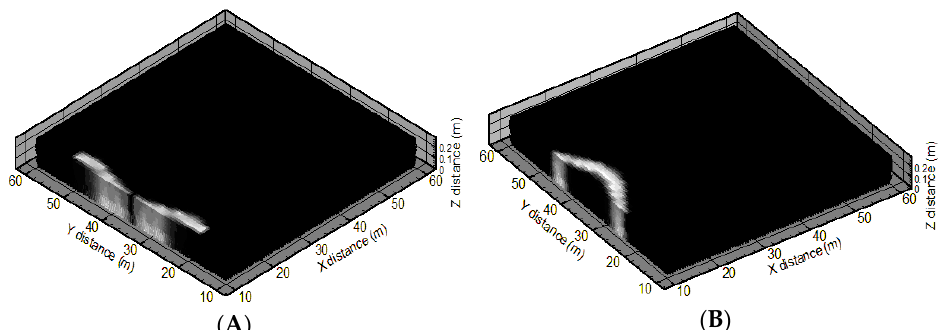
Figure 3. Ignition line after 7 s: ( A ) edge-to-centre ignition and ( B ) centre-to-edge ignition. The edge of the light is marked by any temperature above 500 K.